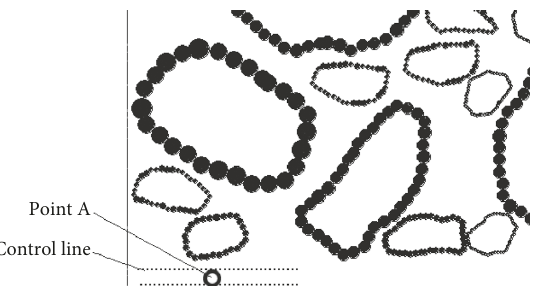
Figure 9: Distinguishing the position of mastic balls without any entities nearby in two sides.